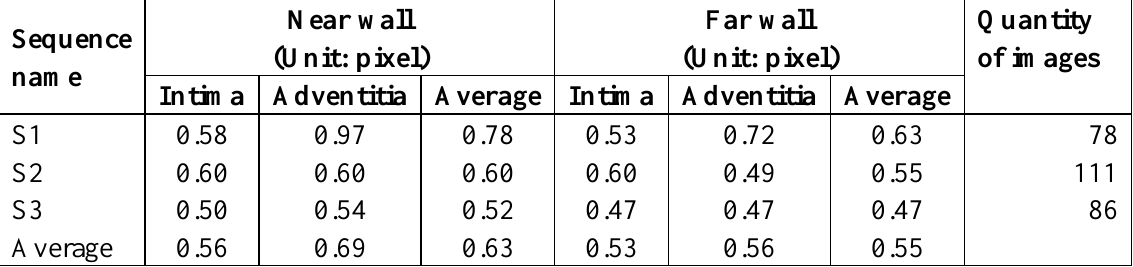
Table 1. Averaged errors of proposed method comparing to manual